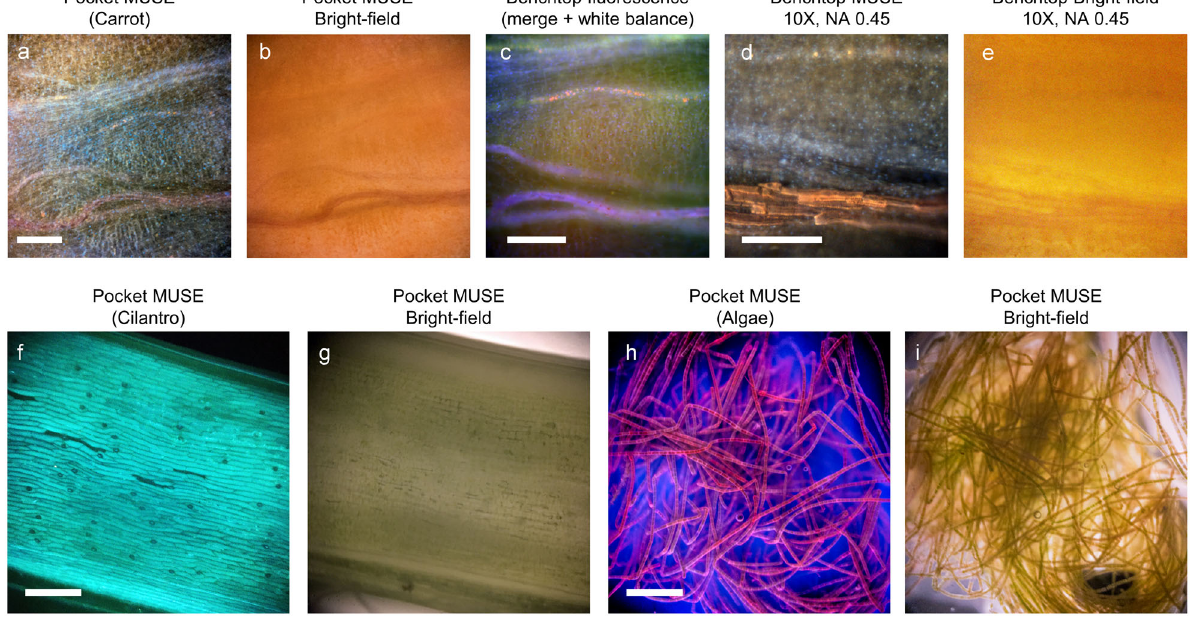
Fig. 5 Comparisons between Pocket MUSE imaging and other imaging modalities. A slice of carrot stained with 0.05% w/v rhodamine B and 0.01% w/v DAPI was imaged with ( a ) UV illumination on Pocket MUSE. b bright- fi eld illumination on Pocket MUSE, ( c ) a benchtop fl uorescence microscope using 405/488/594 nm excitation light and a 10× objective, ( d ) benchtop MUSE microscope, and ( e ) benchtop microscope with bright- fi eld illumination. Additional comparisons of Pocket MUSE images with MUSE illumination (left) and bright- fi eld illumination (right) show ( f ) and ( g ) the surface of a cilantro stem (no staining), and ( h ) and ( i ) a cluster of fi lamentous algae stained with 0.05% w/v propidium iodide followed by rinsing in 1% w/v hydroquinone. Additional images are shown in Supplementary Fig. 4.11. Scale bars: 300 µ